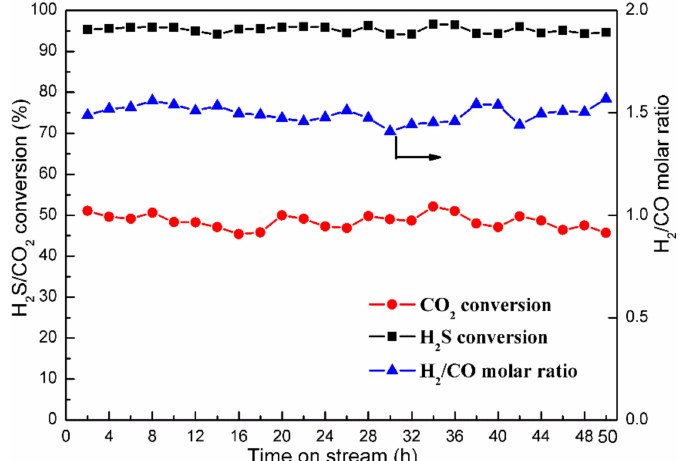
Figure 8. Variations of CO 2 and H 2 S conversion and H 2 / CO molar ratio with time in the plasma-induced conversion over 5Ni-3Mo / Al 2 O 3 . Reaction conditions: H 2 S / CO 2 molar ratio = 20:15; flow rate: 35 mL / min; catalyst bed volume: 15.0 mL; SEI: 50.0 kJ /